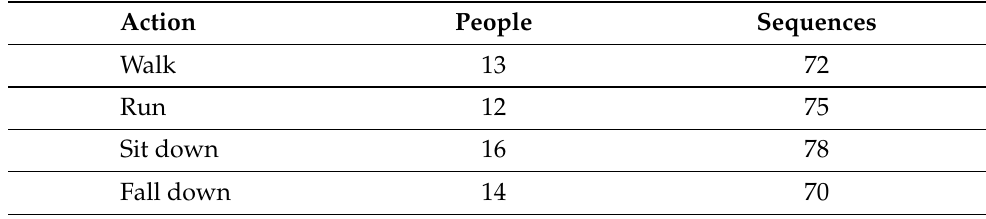
Table 2. Number of sequences and individuals performing any of the 4 actions in GBA dataset